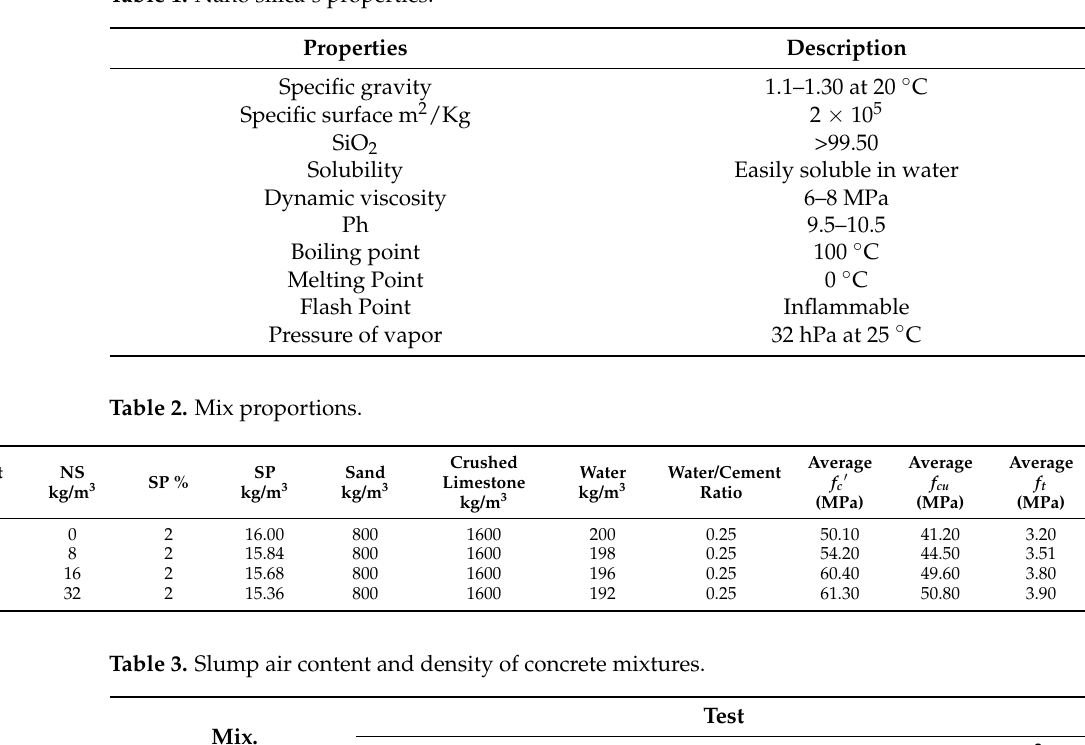
Table 1. Nano silica’s properties.